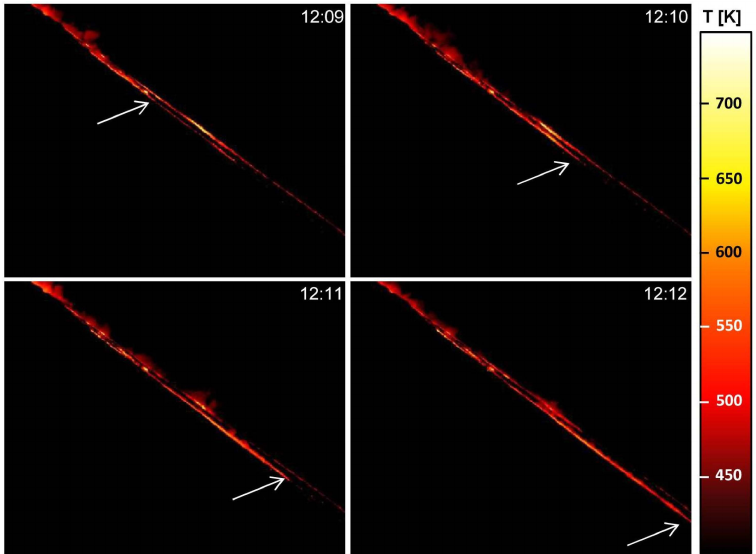
Figure 3. The lava front movement between 12:09 and 12:12 on 18 September 2014 was observed with an Infratec Image IR camera (3.9 µ m filter). At a distance of 850 m from the lava, the images cover a field of view measuring 326 ˆ 261 m. The arrows point to the lava front, which moved 220 m down the slope in 3 min (see Table